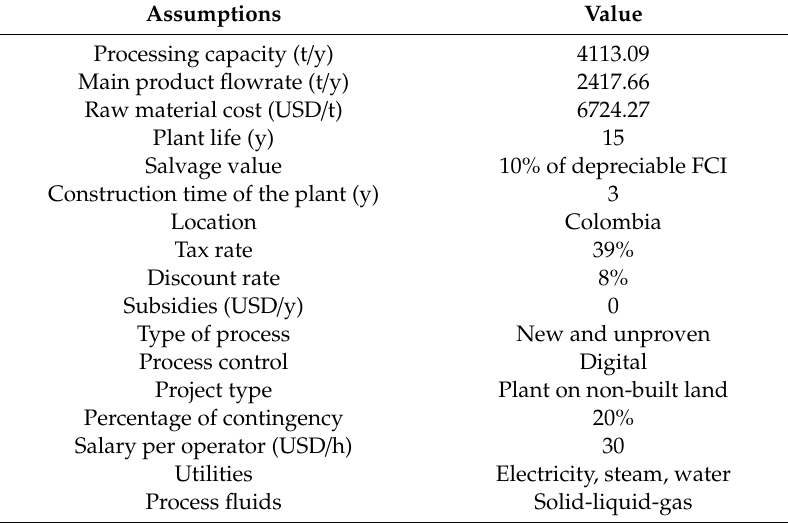
Table 2. Economic assumptions for the integrated approach of shrimp biorefinery.